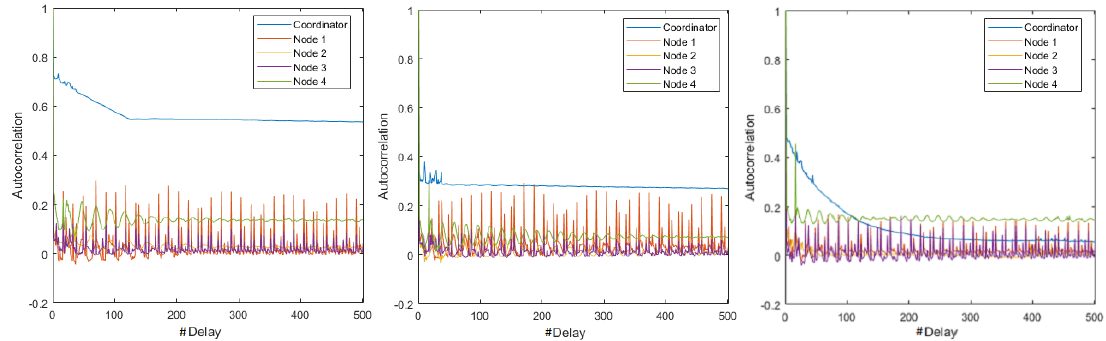
Figure A5. Time signals of SAF for DigiMesh network at 9600 bauds. From left to right: Realizations 1, 4, and